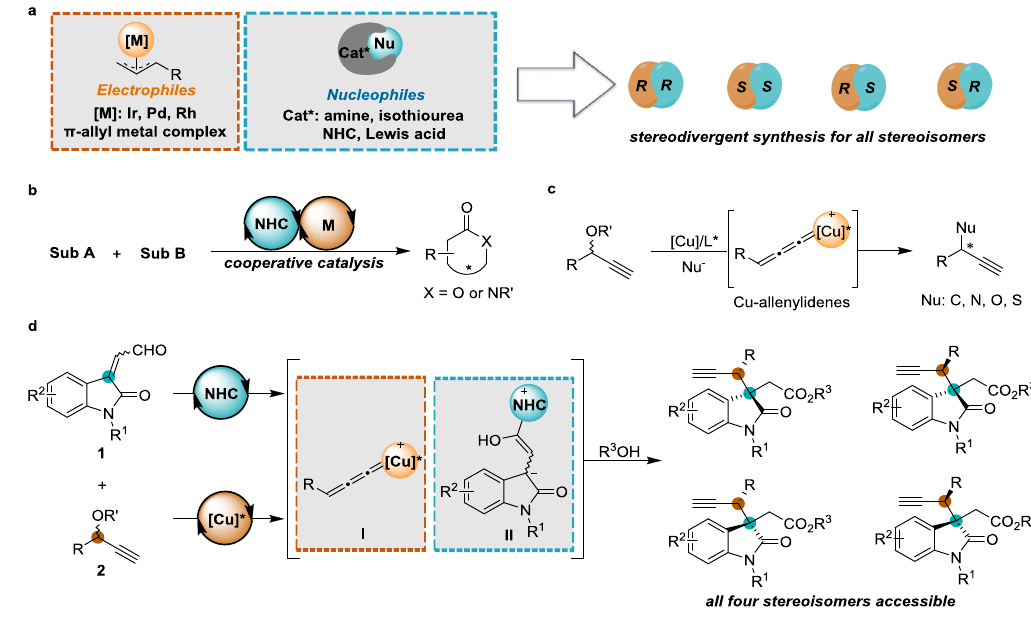
Fig. 1 Stereodivergent synthesis via dual catalysis. a Representative stereodivergent synthesis via cooperative catalysis, chiral catalyst (Cat*). b NHC/ transition metal cooperatively catalyzed enantioselective annulation reactions, substrate (sub). c Asymmetric propargylic substitution reactions mediated by chiral Cu-allenylidene complexes. d This work: the fi rst stereodivergent propargylation of enals via cooperative NHC/copper catalysis, leading to all four stereoisomers with excellent optical